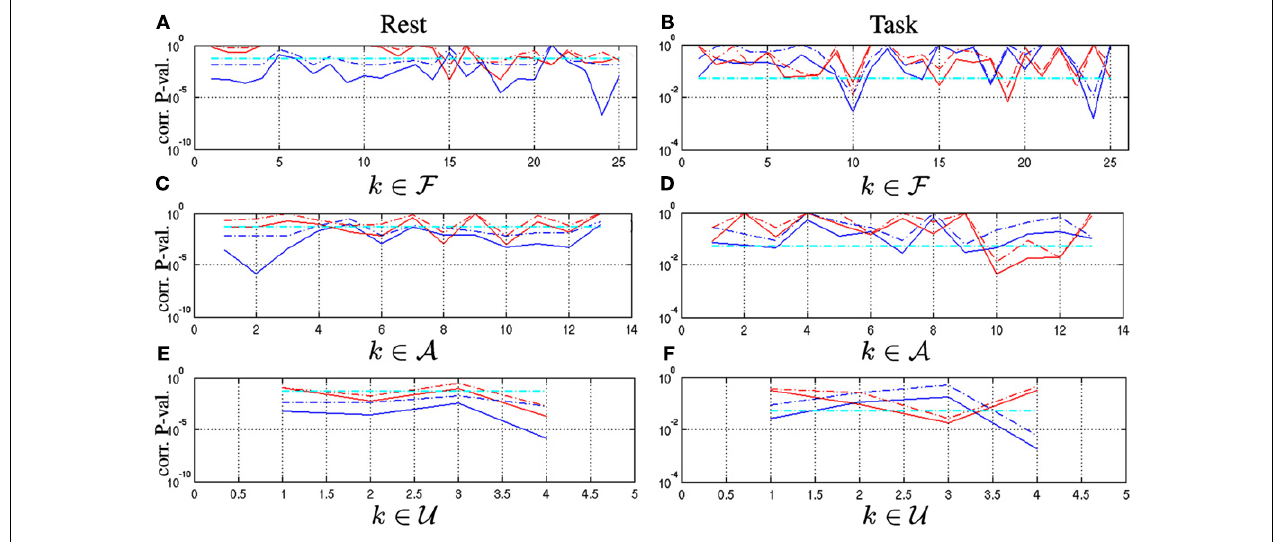
FIGURE 5 | Corrected p-values associated with one-sample Student-t (–,–) andWSR (-.,-.) tests performed on resting-state ([A,C,E]) and task-related multifractal parameters ([B,D,F]) for assessing